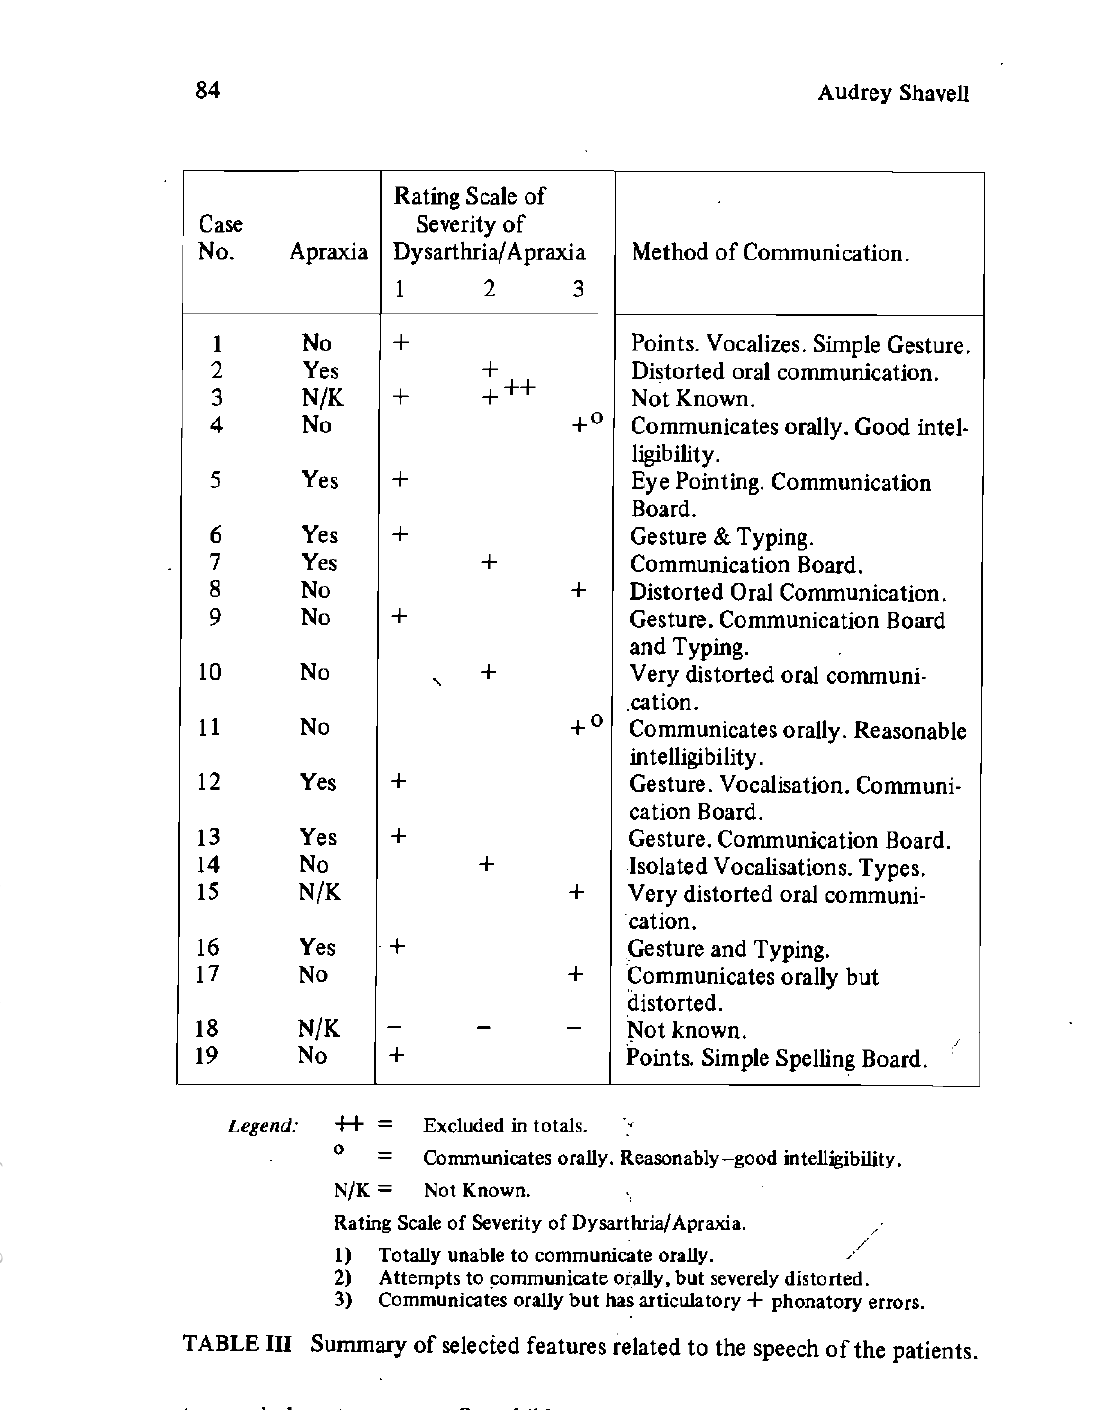
TABLE III Summary of selected features related to the speech of the patients. tory and phonatory errors. One child (case No. 4) had speech completely within normal limits although she was a severe drooler and another child (case No. 11) has intelligible speech after several years of speech